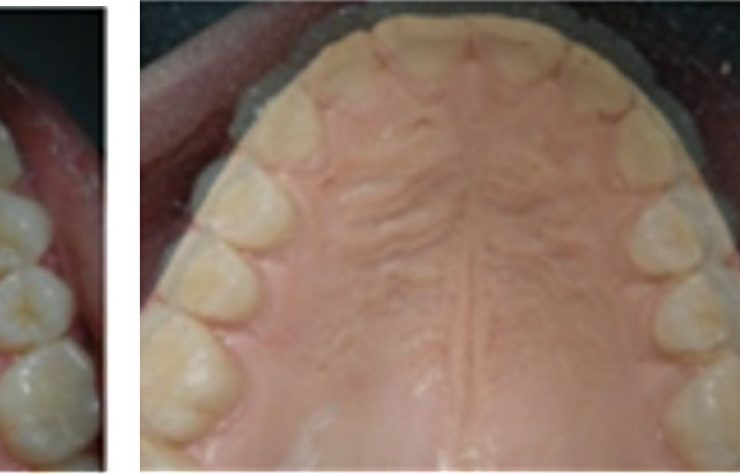
Fig. 1 - Photograph of palatal rugae.